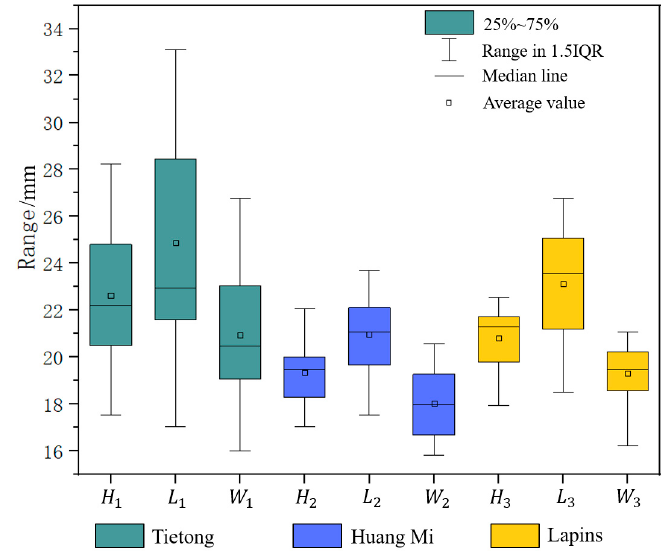
Figure 3. Size of tested sweet cherries.